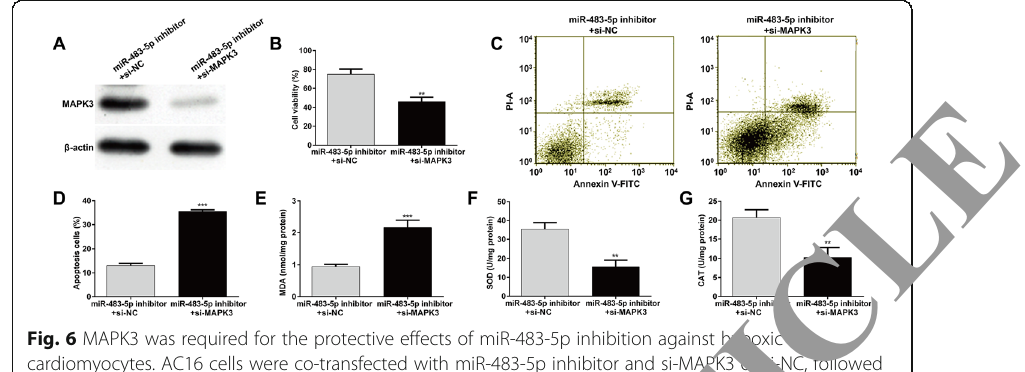
Fig. 6 MAPK3 was required for the protective effects of miR-483-5p inhibition against hypoxic cardiomyocytes. AC16 cells were co-transfected with miR-483-5p inhibitor and si-MAPK3 or si-NC, followed by 24 h hypoxia treatment. a Western blotting was performed to determine the protein expression of MAPK3. b Cell viability was measured using a CCK-8 assay. c and d Cell apoptosis was analyzed using flow cytometry with double Annexin V FITC-PI staining. e through g The content of MDA, the activities SOD and CAT were measured using commercial assay kits. Data are indicated as means ± SD of three independent experiments. ** p < 0.01, *** p < 0.001, as compared with miR-483-5p inhibitor +